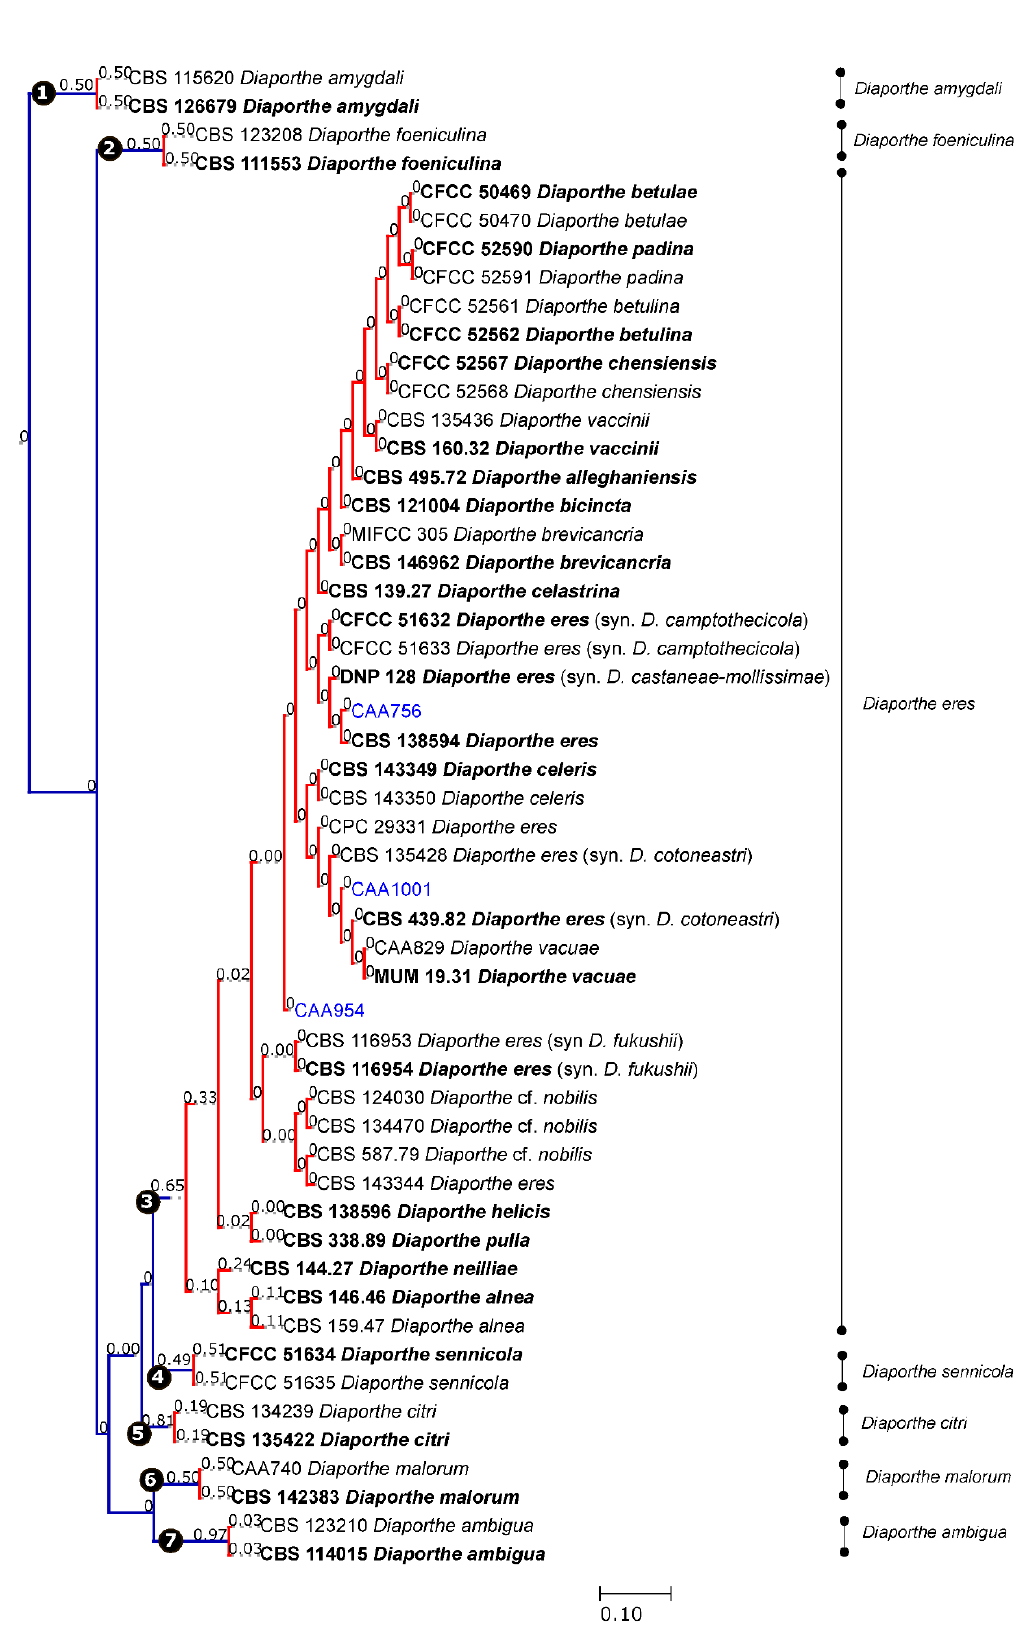
Figure 2. Results of the single PTP analyses for the Diaporthe eres species complex and related taxa, based on Bayesian and Maximum Likelihood topologies. Putative species clusters are indicated using transitions from blue-colored to red-colored branches and represented by circles (1–7). The isolates obtained in this study are indicated in blue.